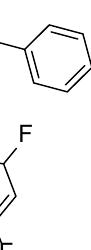
Figure 8. Chemical structure of iodiconazole ( 4 ), a novel triazole antifungal [55].